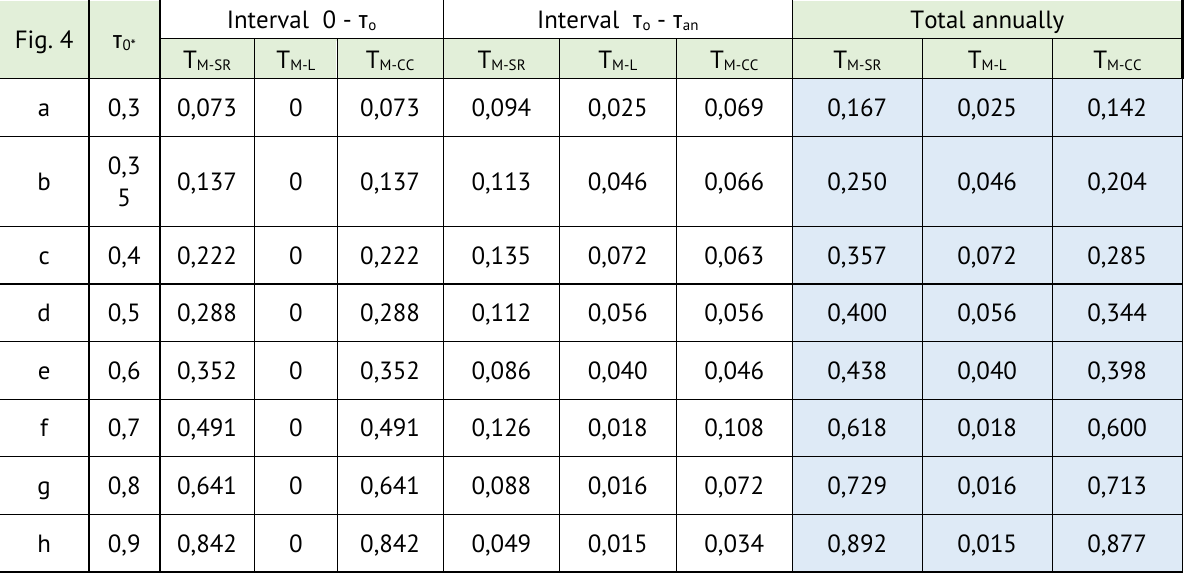
T and T determined for those two intervals, in r.u. M-SR, M-L M-CC